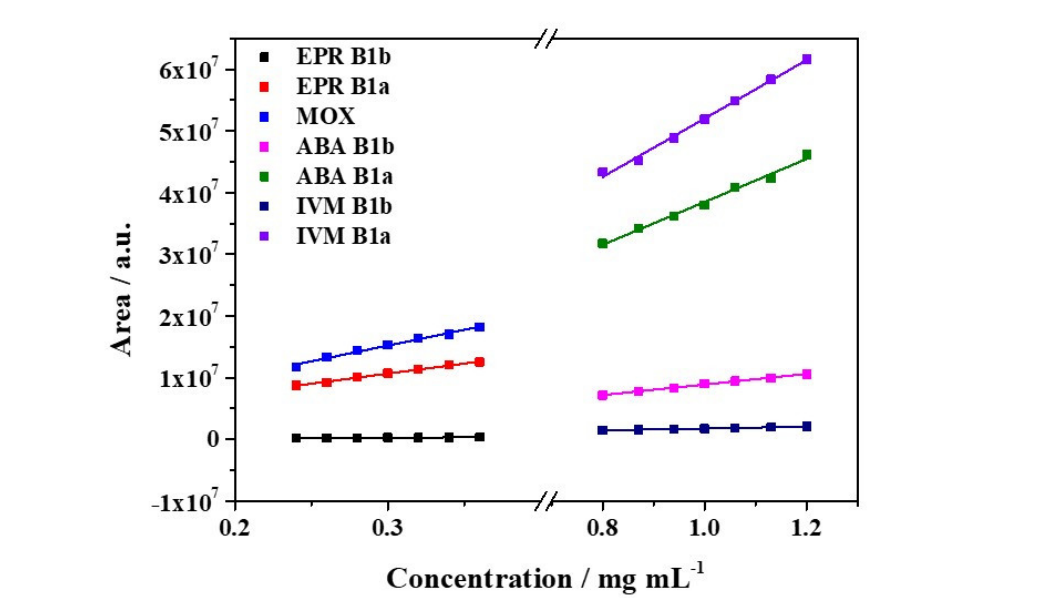
TABLE IV - Limits of detection and quantification of drugs analyzed EPR B1b EPR B1a MOX ABA B1b ABA B1a IVM B1b IVM B1a LOD (mg mL –1 ) 0.003 0.012 LOQ (mg mL –1 ) 0.004